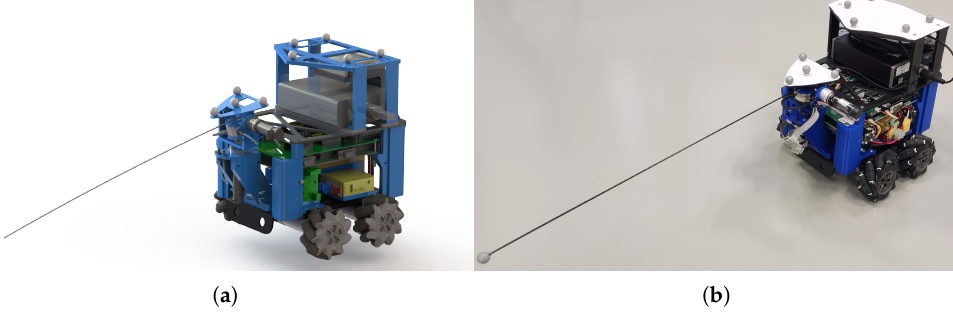
Figure 1. Robotic platform: ( a ) 3D model; ( b ) real